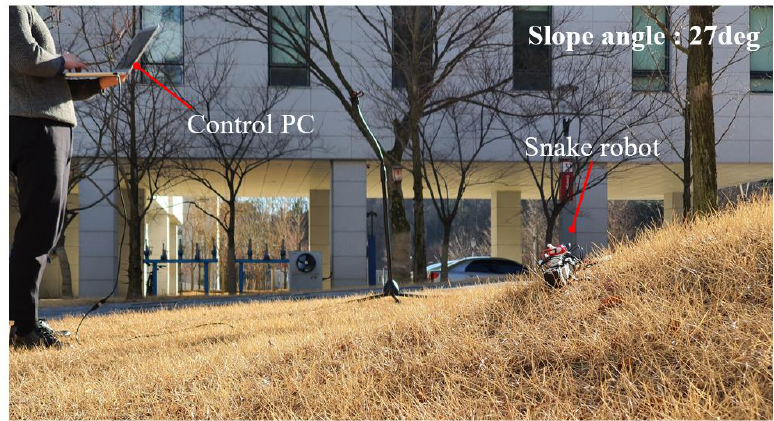
Figure 11. Experiment environment in rough terrain.